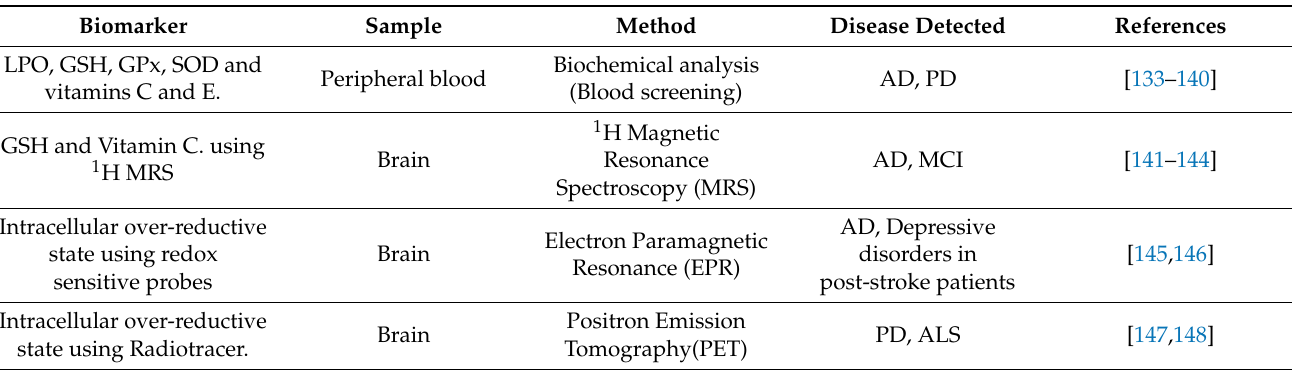
Table 1. Overview of the methods and biomarkers that are used to detect oxidative stress in neurode- generative